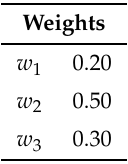
Table 2. Weights for each criterion.